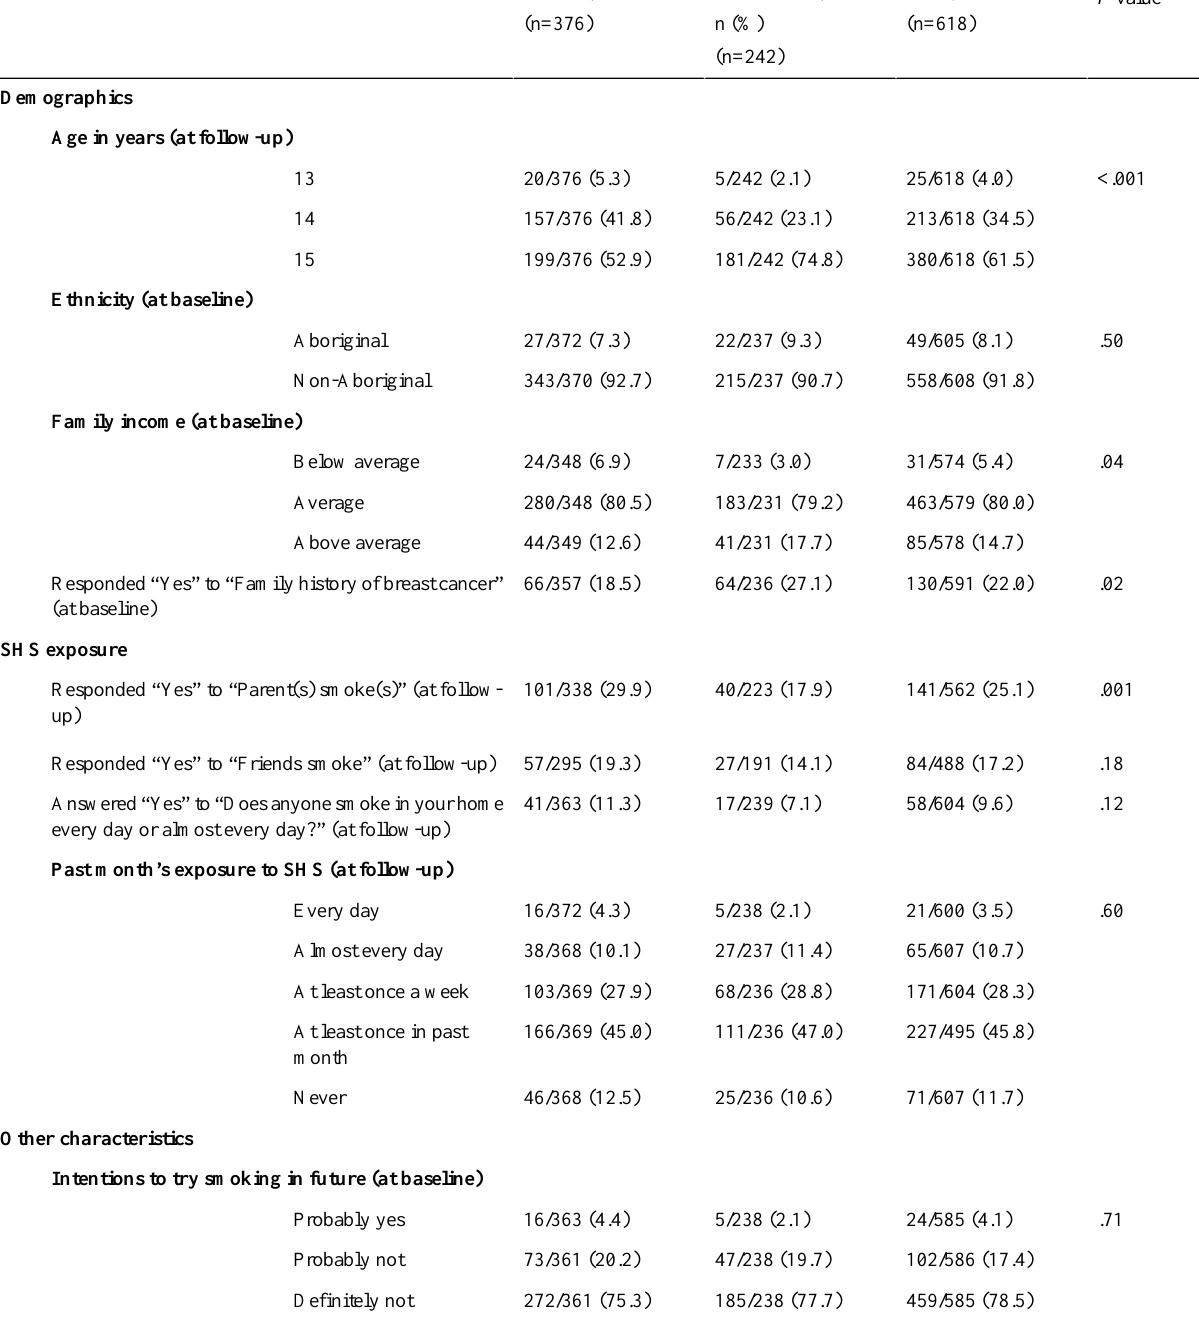
P value a Total, n (%)